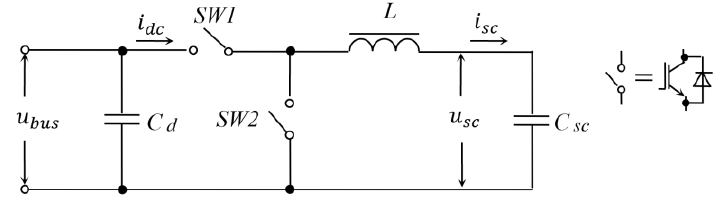
Figure 13. A boost-down converter with super capacitor module.